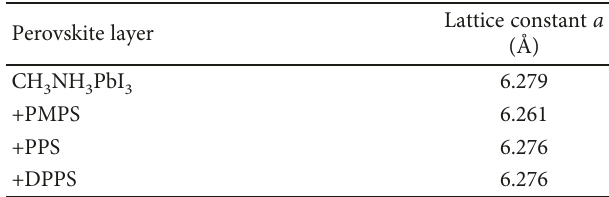
NH PbI solar cells with (b) PMPS, (c) PPS, and (d) DPPS. 3 3 3 Table 2: Measured lattice constants of cubic CH perovskite structures with